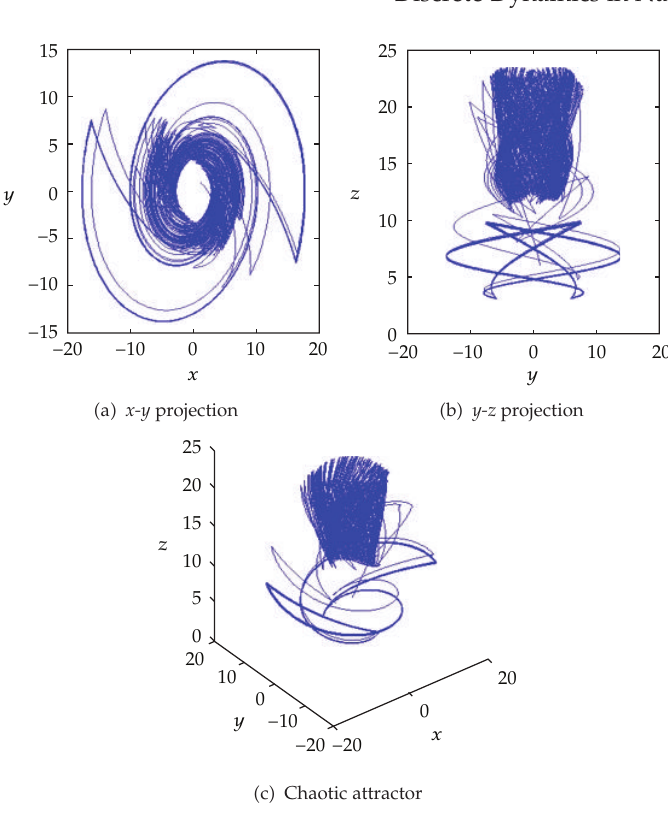
Figure 10: Chaotic attractor generated by G 1 (cid:7) 50, G 2 (cid:7)